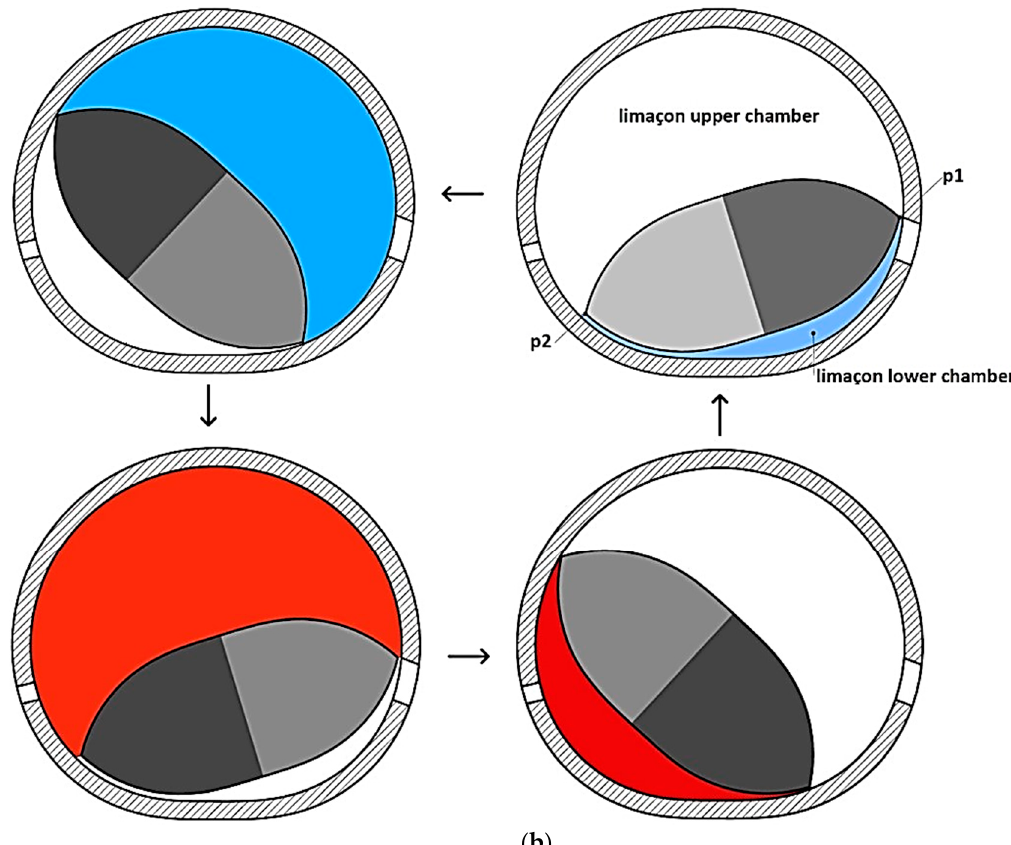
Figure 1. ( a ) The limaçon compressor; ( b ) illustration of the working process (suction is blue and delivery is red).